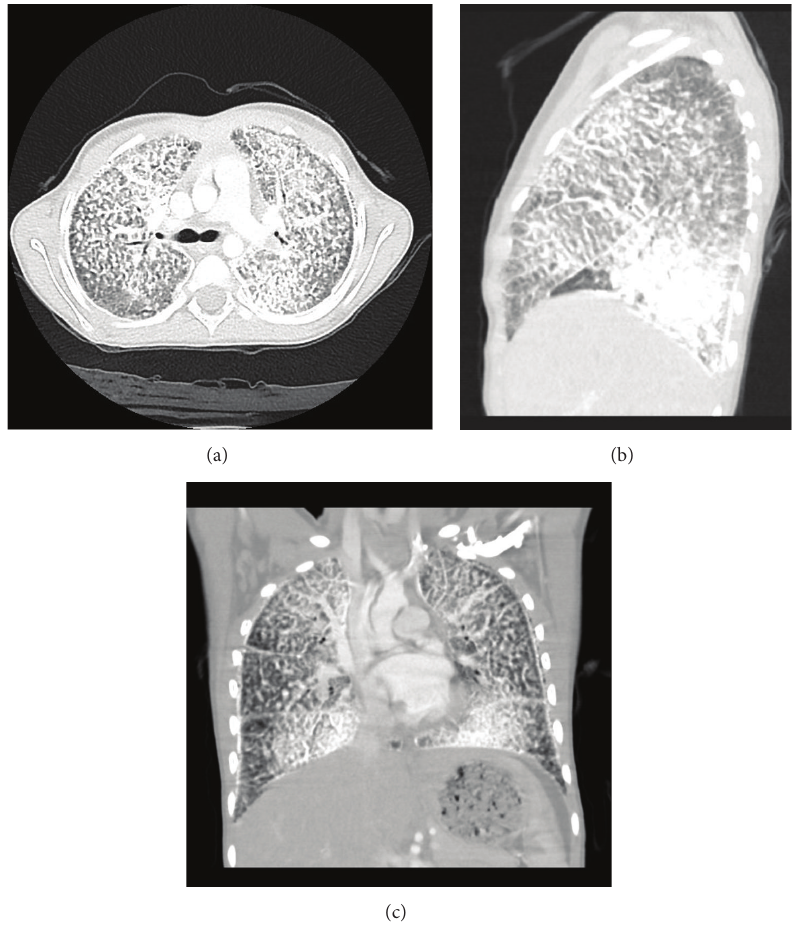
Figure 2: CT. (a) Axial CT image. (b) Sagittal CT image. (c) Coronal CT image.